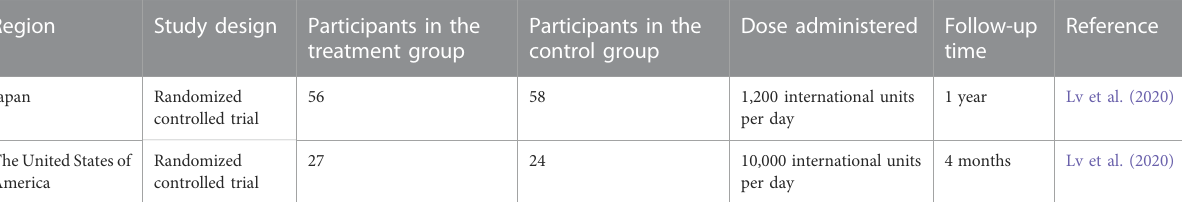
TABLE 2 Studies indicating the administration of vitamin D3 as a supplement. Region